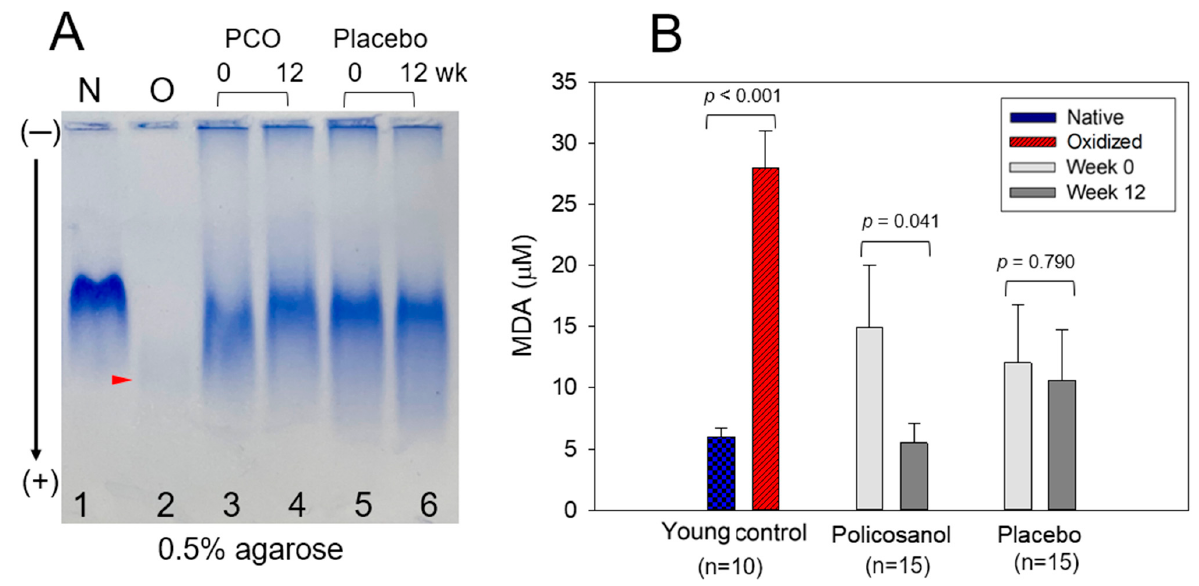
Figure 2. Comparison of the electromobility ( A ) and quantification of oxidation extent ( B ) in VLDL from the policosanol (PCO, 20 mg) and placebo groups. ( A ) Electrophoresis of VLDL on 0.5% agarose gel (120 mm length × 60 mm width × 5 mm thickness) under a nondenatured state. The electrophoresis was carried out with 50 V for 1 h in Tris-acetate-ethylene-diamine-tetraacetic acid buffer (pH 8.0). The apo-B in VLDL was visualized by Coomassie brilliant blue staining (final 1.25%). Lane N, native VLDL (0.5 mg/mL of protein), which was purified from young and healthy control; lane O, oxidized VLDL, cupric ion (final 10 µ M) treated for 4 h; PCO, policosanol. The red arrowhead indicates an oxidized VLDL band. ( B ) Quantification of the oxidized VLDL contents by a thiobarbituric acid reactive substance assay using a malondialdehyde (MDA) standard. The data are expressed as the mean ± SEM from three independent experiments with duplicate samples. In young control, cupric ion (final 10 µ M) treated VLDL (O) was compared with native VLDL alone (N) by a paired t -test. The extent of oxidation in each group between weeks 0 and 12 was compared using a paired t -test. N, native VLDL from young and healthy male volunteers; O, cupric ion treated VLDL (oxidized